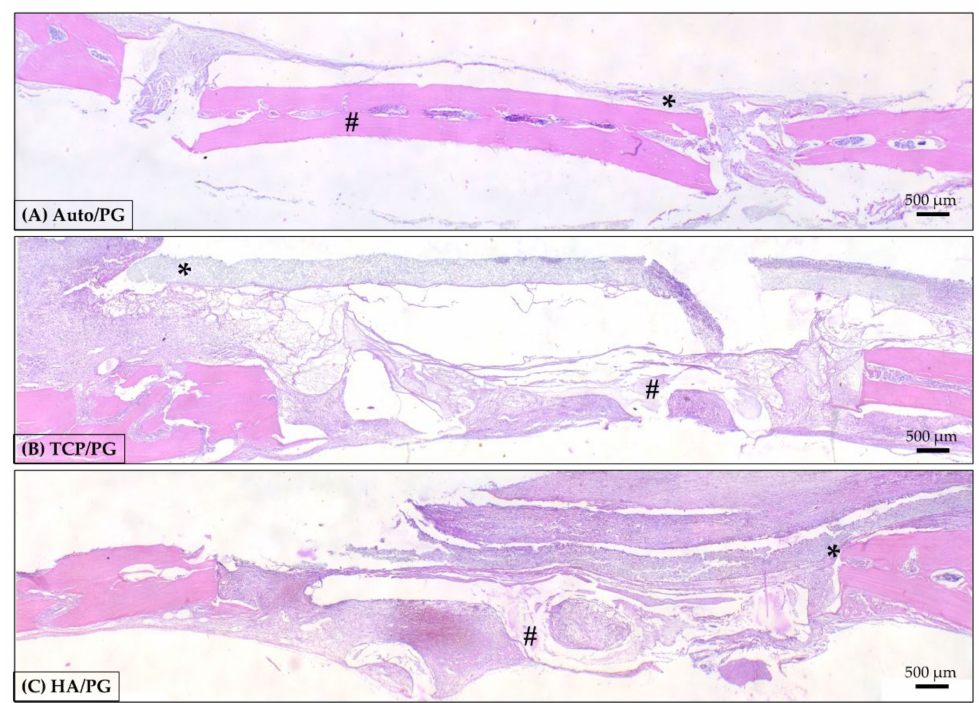
Figure 4. Representative photomicrographs of Auto/PG, TCP/PG, and HA/PG at 7-day histological analysis. ( A ): Auto/PG group; ( B ): TCP/PG group; ( C ): HA/PG group Staining: Hematoxylin and eosin. Legend: * PDO membrane; # autogenous block and 3D-printed blocks. Scale bar: 500 µ m (4 × magnification).